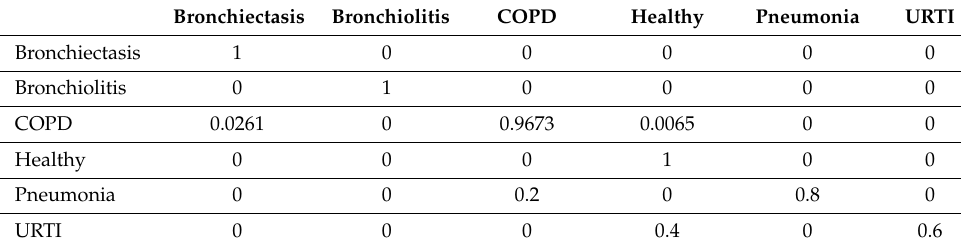
Table 15. Confusion matrix of the proposed ensemble model for D1, i.e., the ICBHI